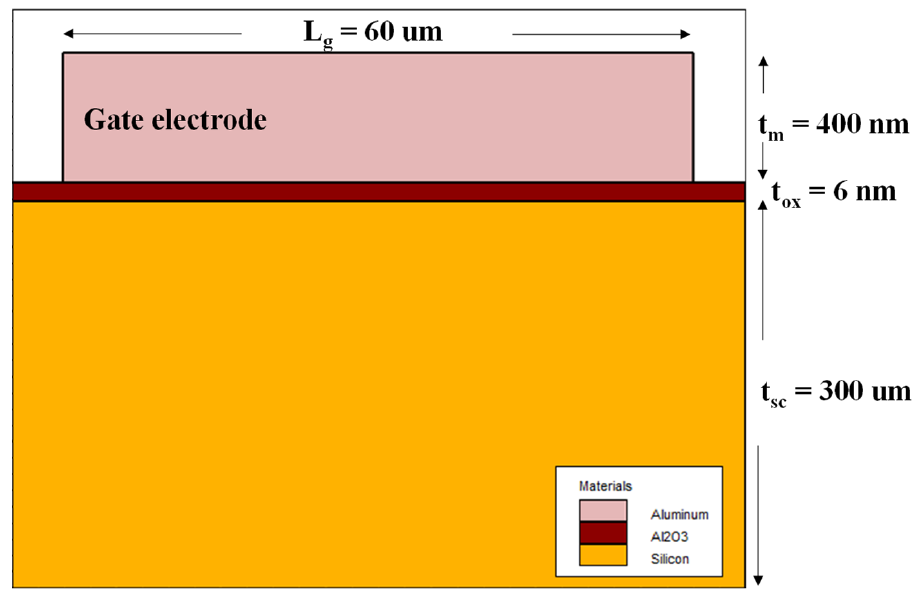
Figure 7. Schematic diagram of simulated structure on Silvaco TCAD with Athena tool.